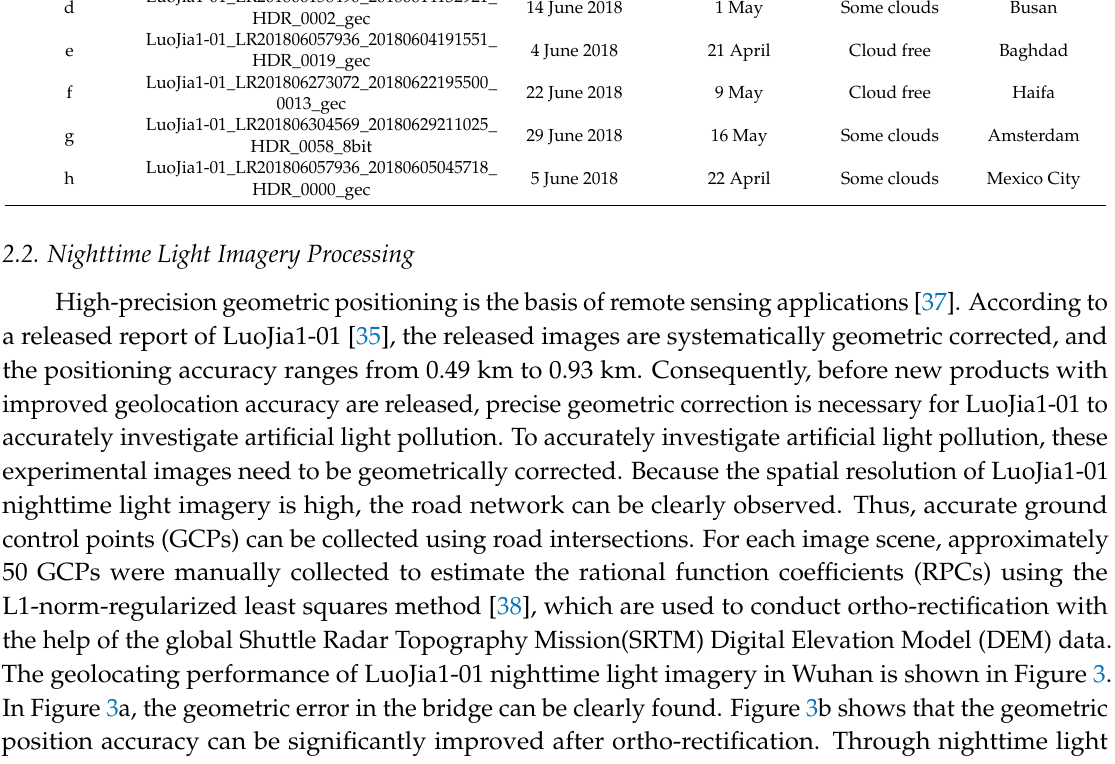
Table 2. The description of experiment data used in this study.